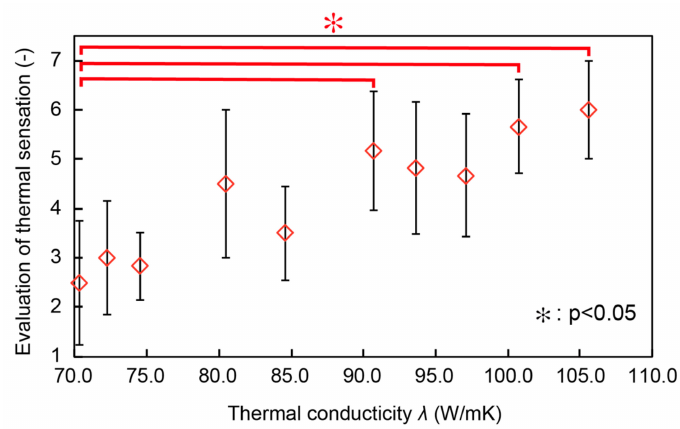
Figure 8. Evaluation of thermal sensation using the semantic di ff erential (SD) method.